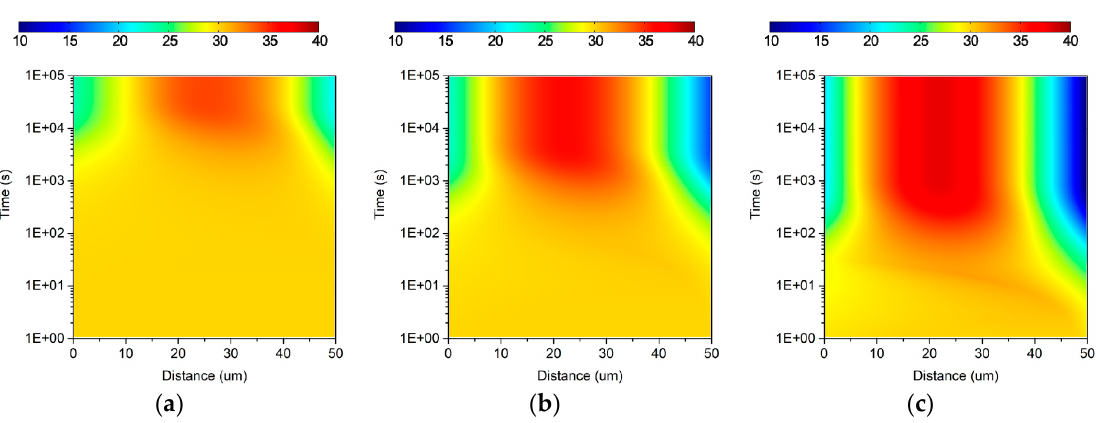
Figure 11. Time-dependent electric field distribution under DC stress only at different temperature conditions: (a) electric field (kV/mm) at room temperature (=20 °C); (b) electric field (kV/mm) at 40 °C; (c) electric field (kV/mm) at 60 °C.